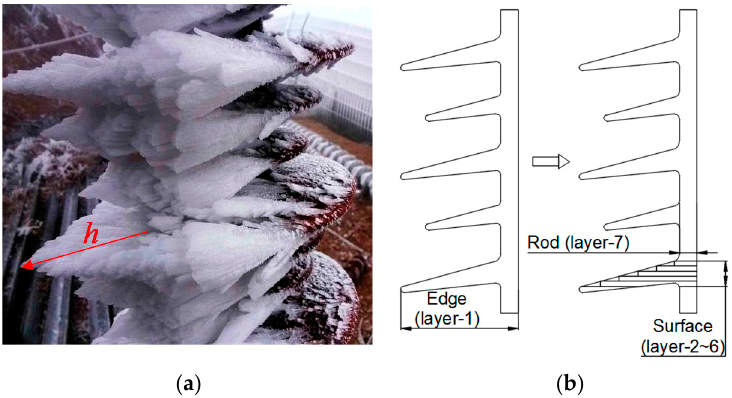
Figure 1. ( a ) The dry-growth icing shape and ( b ) layer-divided structure of insulator type A.